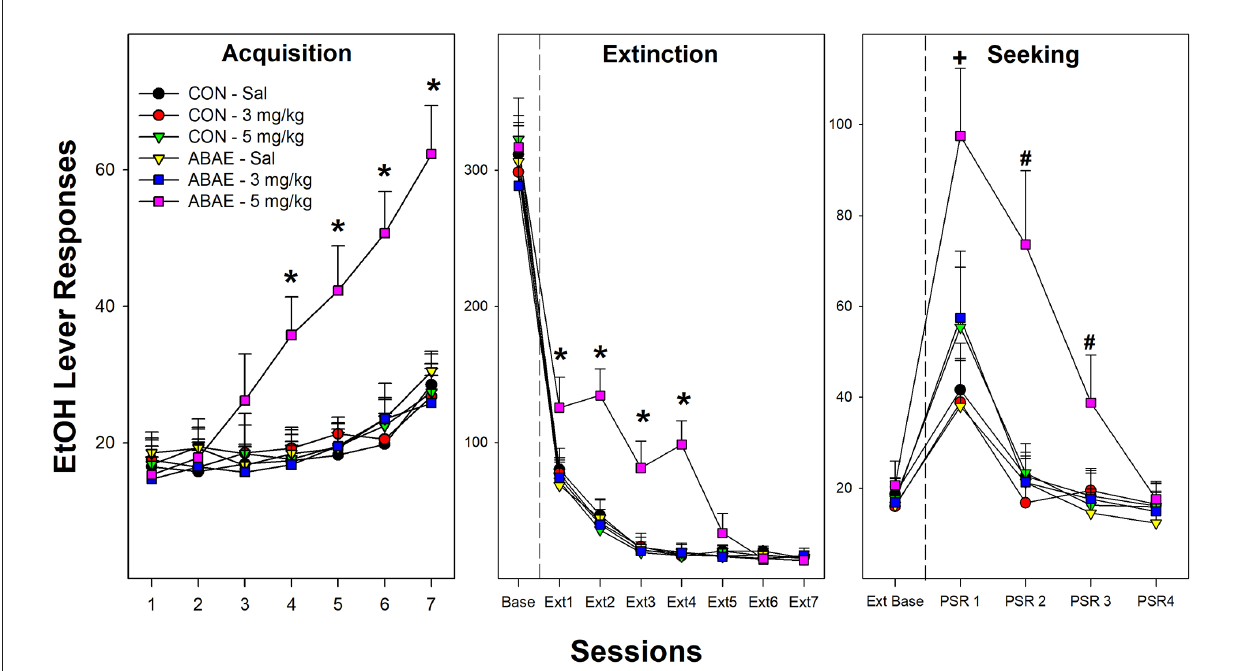
FIGURE6 Depicts the mean (+ SEM) number of EtOH (beer) lever responses in female Wistar rats as a product of exposure to low-dose ABAE (2 g/kg) and treatment with the α 7 PAM PNU. During Acquisition of responding (left panel), female rats treated with 2 g/kg ABAE and 5 mg/kg PNU during adolescence responded more on the lever associated with the delivery of beer (7.7% West Coast IPA; *indicates significant difference from all other groups). Rats treated with 2 g/kg ABAE and 5 mg/kg PNU during adolescence responded more on the lever previously associated with the delivery of beer during the first four Extinction training sessions (middle panel; *indicates significant difference from all other groups). During context-induced EtOH-seeking(right panel),femaleWistar ratstreatedwith 2g/kgABAE and5mg/kg PNUduringadolescence respondedmoreonthe leverpreviously associated with the delivery of beer than all other groups during sessions 1–3. + sign indicates that all groups displayed an increase in responding compared to extinction baseline, and 2 g/kg ABAE and 5 mg/kg PNU are significantly higher than all other groups. # sign indicates that 2 g/kg ABAE and 5 mg/kg PNU are significantly higher than all other groups and higher than extinction